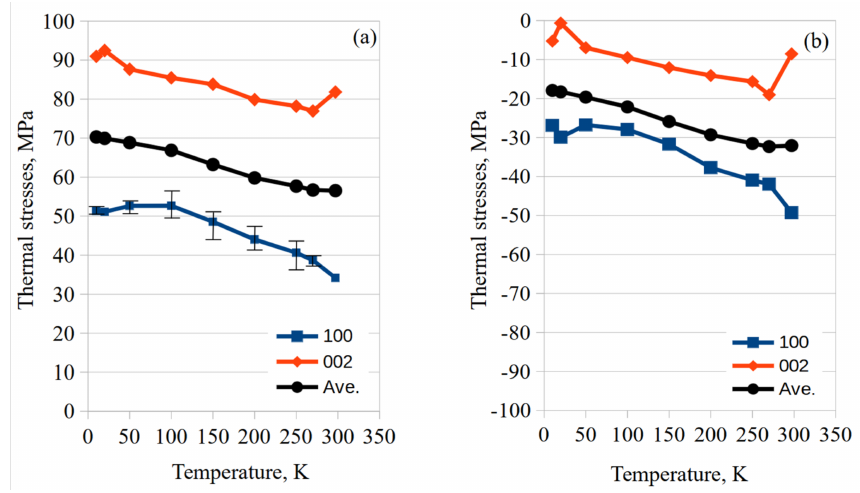
Figure 9. Stress alterations of the titanium matrix in the W/Ti composite: ( a ) the longitudinal direction of tungsten fibers; ( b ) the normal direction.